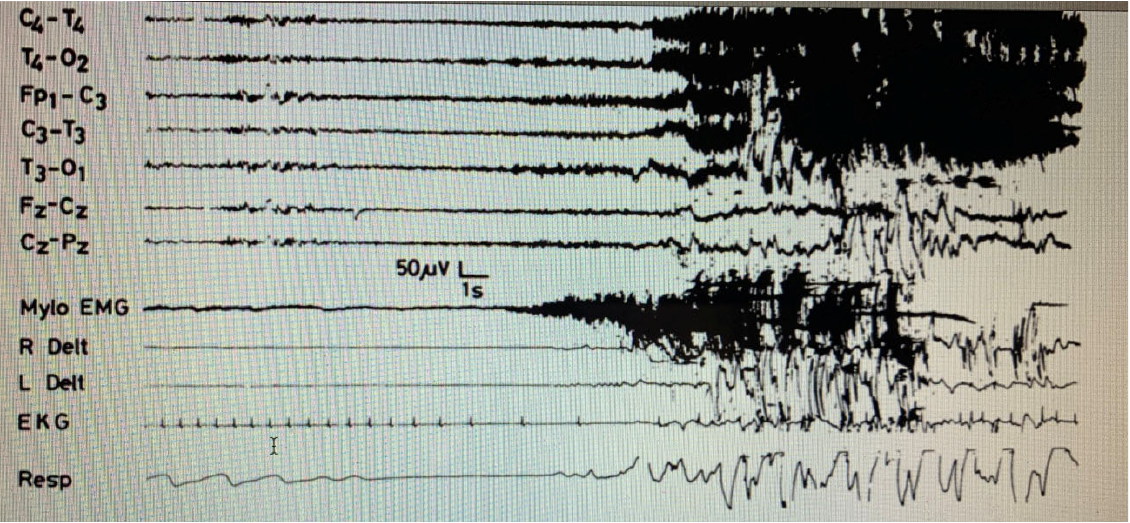
Figure 18. An episode of nocturnal paroxysmal dystonia. The episodes occur in NREM sleep here in stage 2 sleep. The chin muscle (mylo EMG) channel shows an increase in muscle tone and there are also movement artifacts in the deltoid EMGs and elsewhere. The episode lasted about 15 sec and the patient remained asleep. (Reproduced with permission from Lugaresi E, Cirignotta F and Mon ‐ tagna P. Nocturnal paroxysmal dystonia. J Neurol Neurosurg Psychiatry. 1986; 49: 375–380 Pub ‐ lished by BMJ